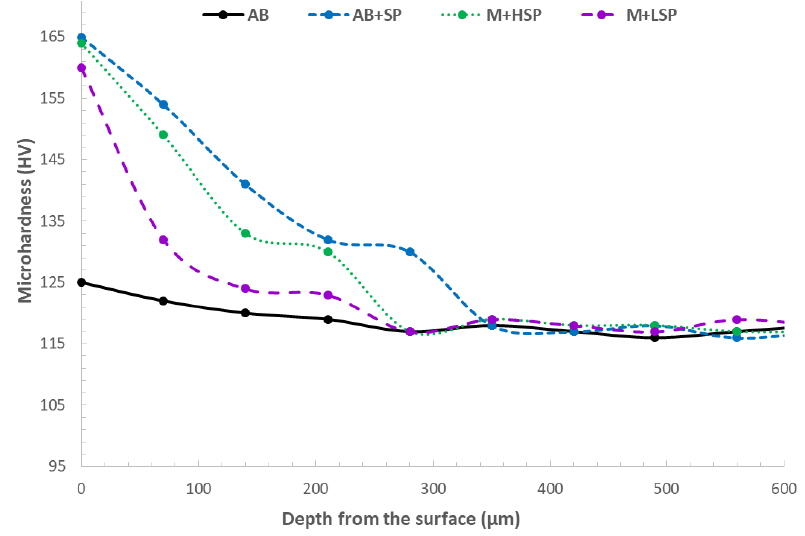
Figure 10. The in-depth microhardness profile of the AlSi10Mg samples under various SP conditions. Table 5. Surface microhardness of the AlSi10Mg samples under various conditions.